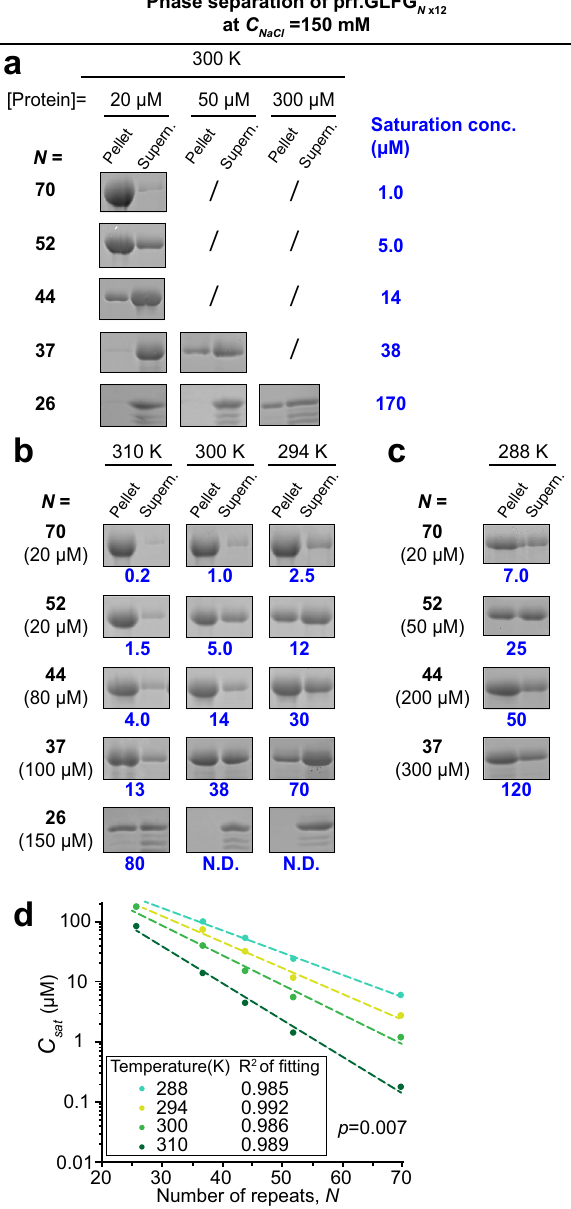
Fig. 5 | Saturation concentrations decrease exponentially with increasing FG repeat numbers. a – c Dilutions of variants containing different number of con- nected perfect repeats ( N ) were centrifuged and SDS samples of the obtained pellets (FG phase) and supernatants were loaded for SDS-PAGE at equal ratio. C sat for each condition were determined as described above, and are shown in blue. Assay temperatures and concentrations of the dilutions of the variants are as indicated. Concentration of NaCl in the assay buffer was the same, 150mM for ( a – c ). Experiments for each condition were repeated two times on independent samples with similar results and the mean values are shown. Marked with “ / ” or “ N.D ” : not determined. Full scans of gels with molecular weight markers are pro- vided in the Source data fi le. d C sat obtained above at different temperatures were plotted against the number of perfect repeats ( N ). Each dataset for a given tem- perature can be fi tted with a simple exponential